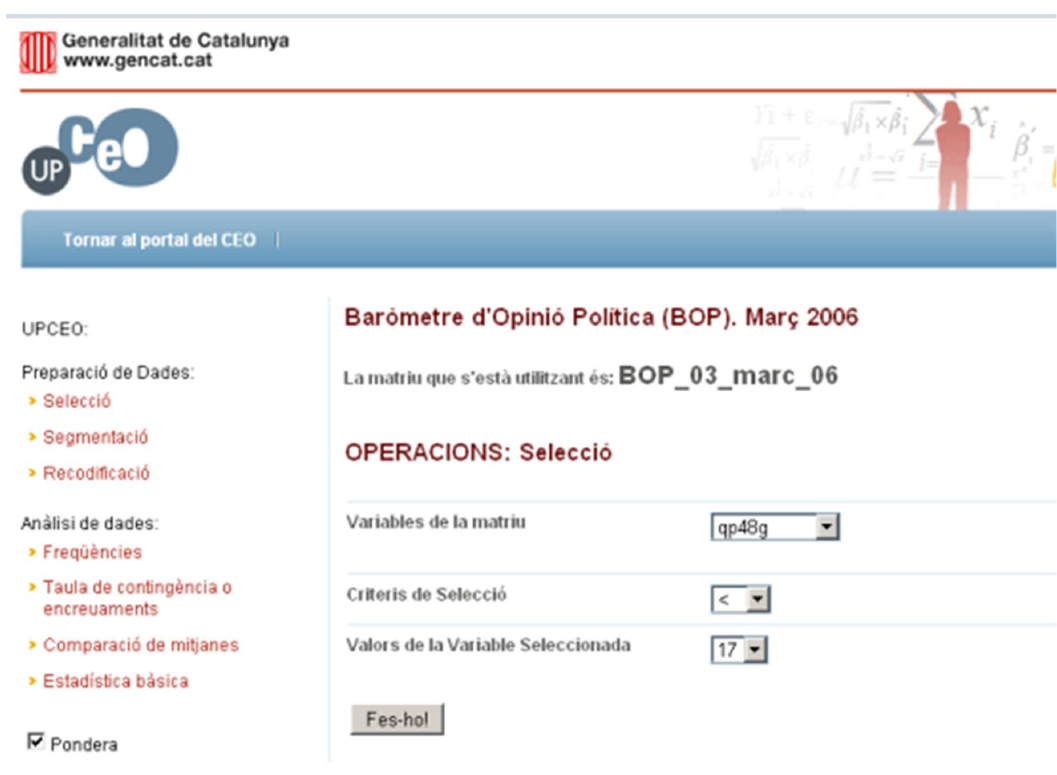
Figure 13. Selection operation.